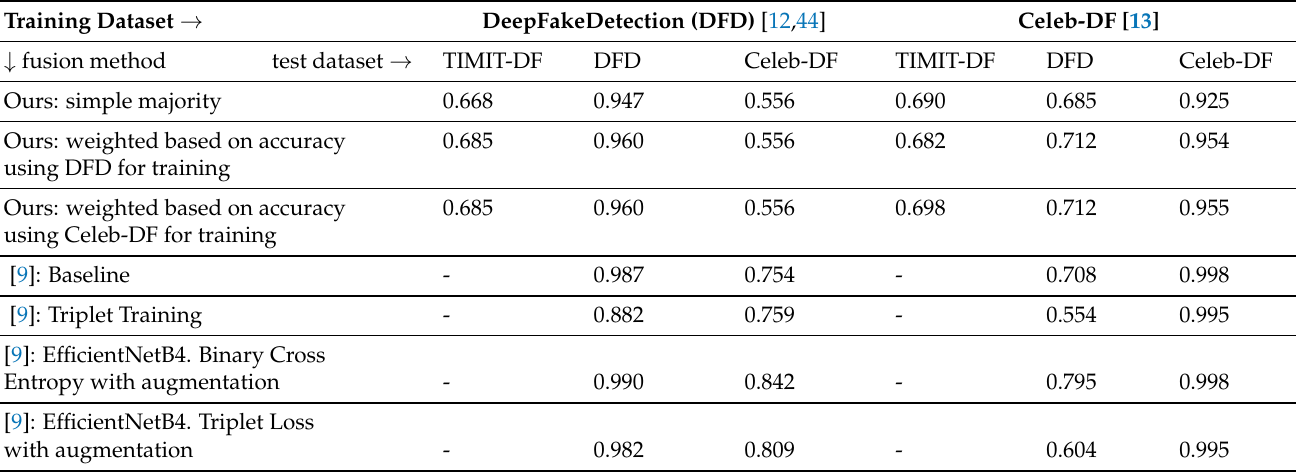
Table 8. Comparison (in terms of AUC) of different state-of-the-art DeepFake detectors with the presented methods. Further separation based on differentiating training and test